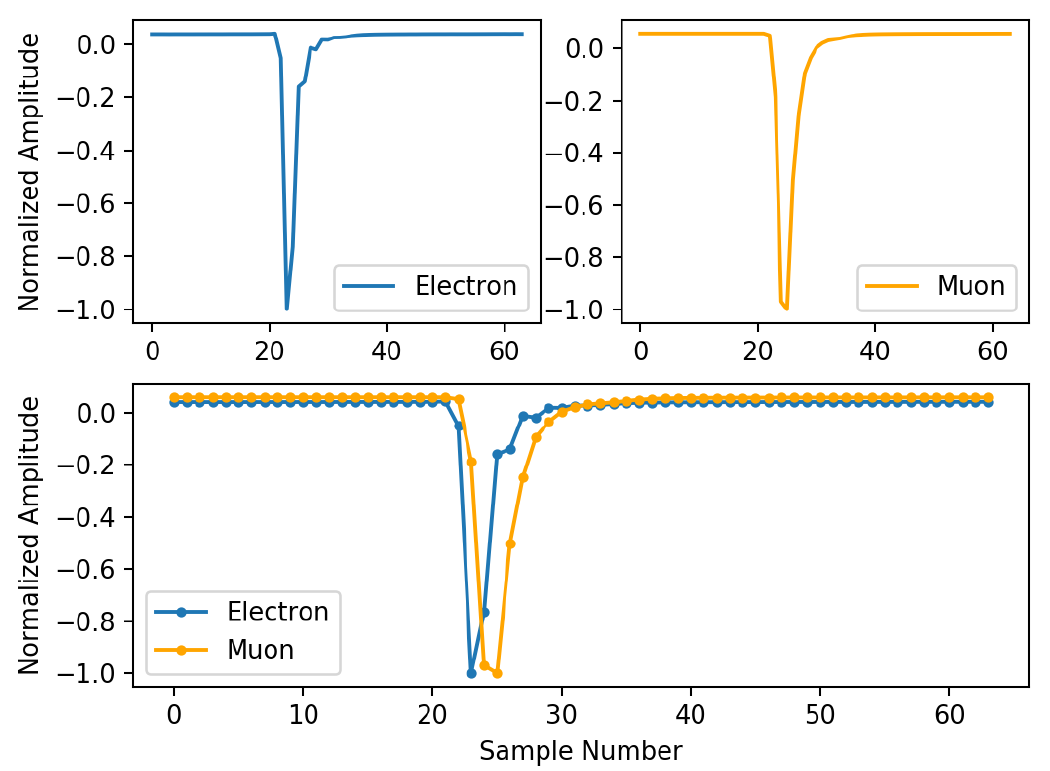
Figure 7. Typical electron and muon signal sampled at 125 MHz normalized in